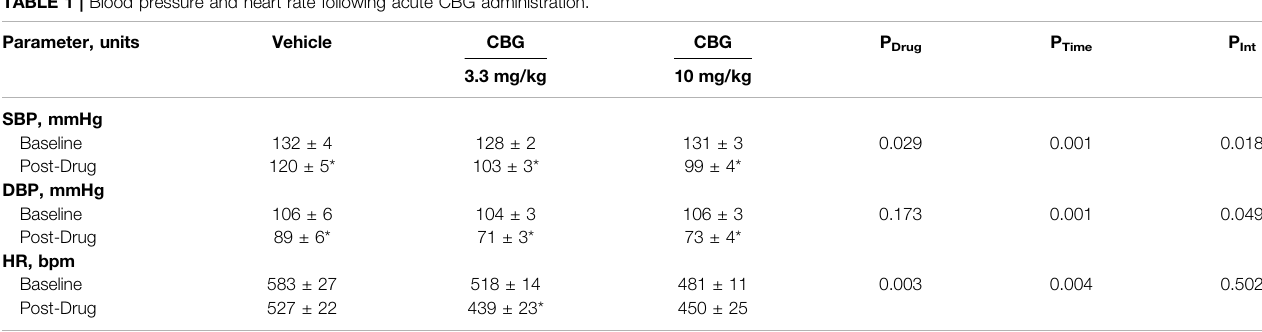
CBG, cannabigerol; SBP, systolic blood pressure; DBP, diastolic blood pressure; HR, heart rate.